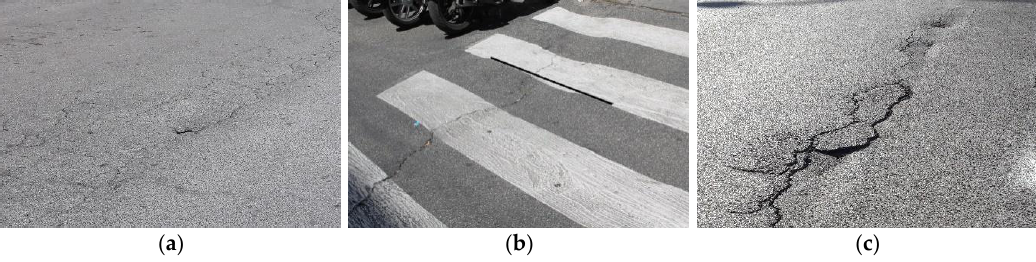
Figure A2. Surface deformations. ( a ) Low Severity; ( b ) Medium Severity; and ( c ) High Severity.